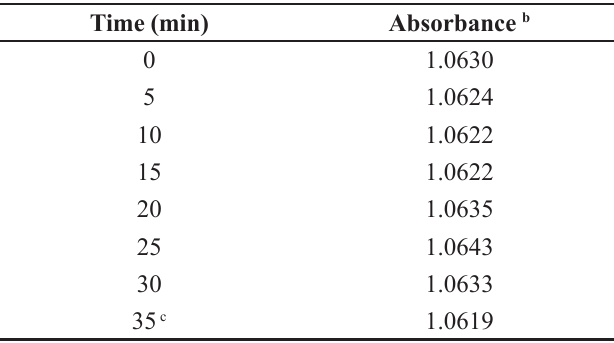
TABLE II - Optical stability of the reaction product at room temperature (25 ° C) a Time